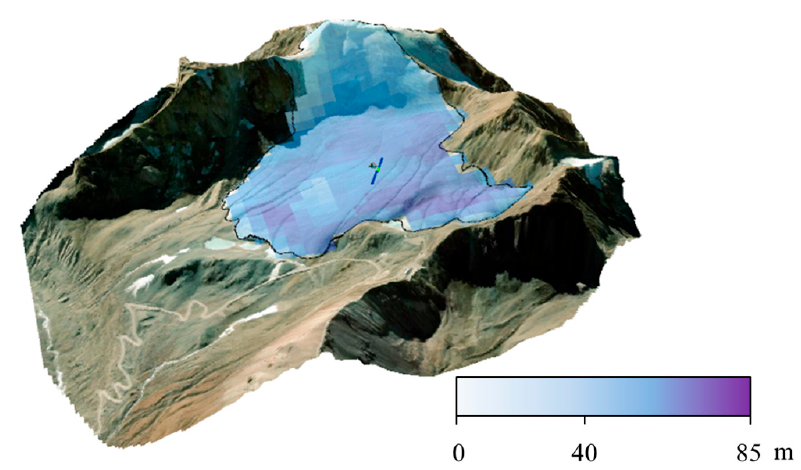
Figure 7. The thickness of the KQGR glacier calculated by glacier surface motion and slope.